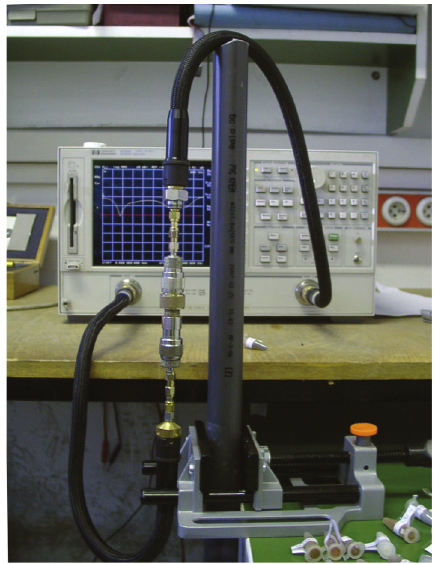
Figure 2: Measurement setup.